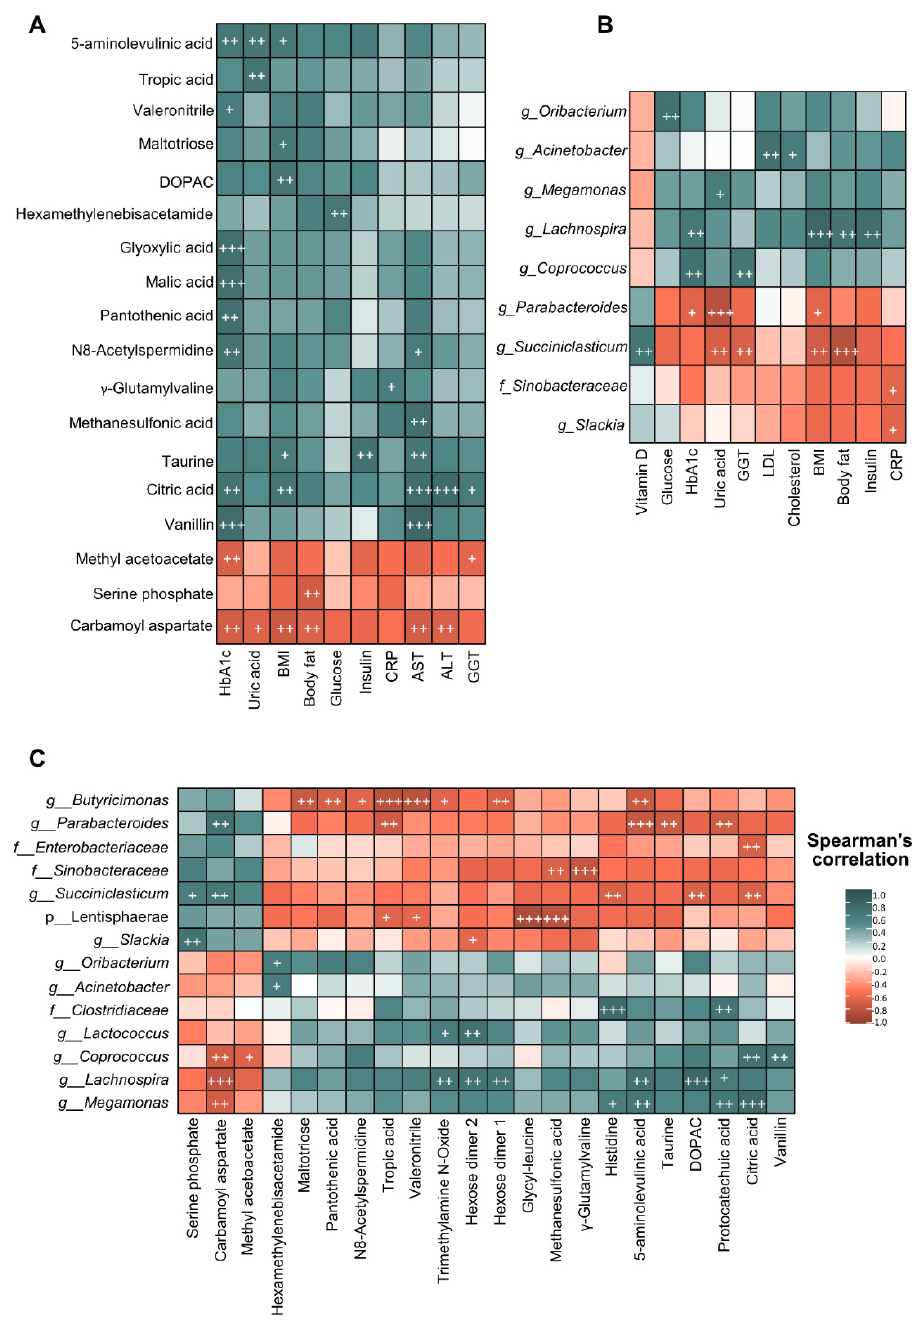
Figure 5. Correlation analysis between biochemical and anthropometric parameters, microbiota composition and the metabolomic profile of patients with severe obesity under bariatric surgery. ( A ) Heatmap of correlations between faecal metabolomic profile and faecal microbiota composition considering results of patients with severe obesity before and after bariatric surgery. ( B ) Heatmap of correlations between faecal metabolomic profile and biochemical and anthropometric parameters considering results of patients with severe obesity before and after bariatric surgery. ( C ) Heatmap of correlations between faecal microbiota composition and biochemical and anthropometric parameters considering results of patients with severe obesity before and after bariatric surgery. Each square represents the Spearman’s correlation coefficient ( p < 0.01). Red and green cells designate positive and negative correlations, respectively. White crosses denote level of significance + p < 0.01, ++ p < 0.005, +++ p < 0.001.